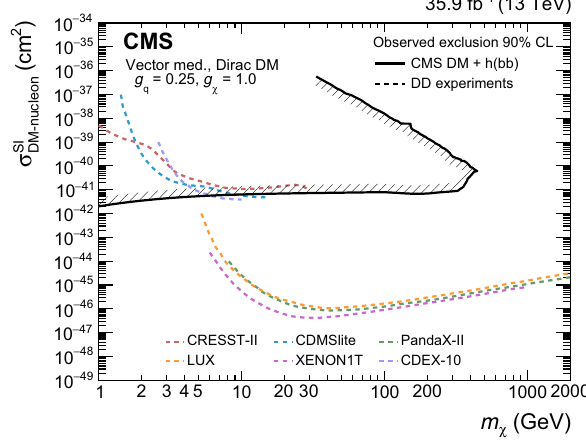
Fig. 8 The 90% CL exclusion limits on the DM-nucleon SI scattering cross section as a function of m χ . Results for the baryonic Z (cid:3) model obtained in this analysis are compared with those from a selection of direct detection (DD) experiments. The latter exclude the regions above the curves. Limits from CRESST-II [67], CDMSlite [68], LUX [69], XENON-1T [70], PandaX-II [71], and CDEX-10 [72] are shown